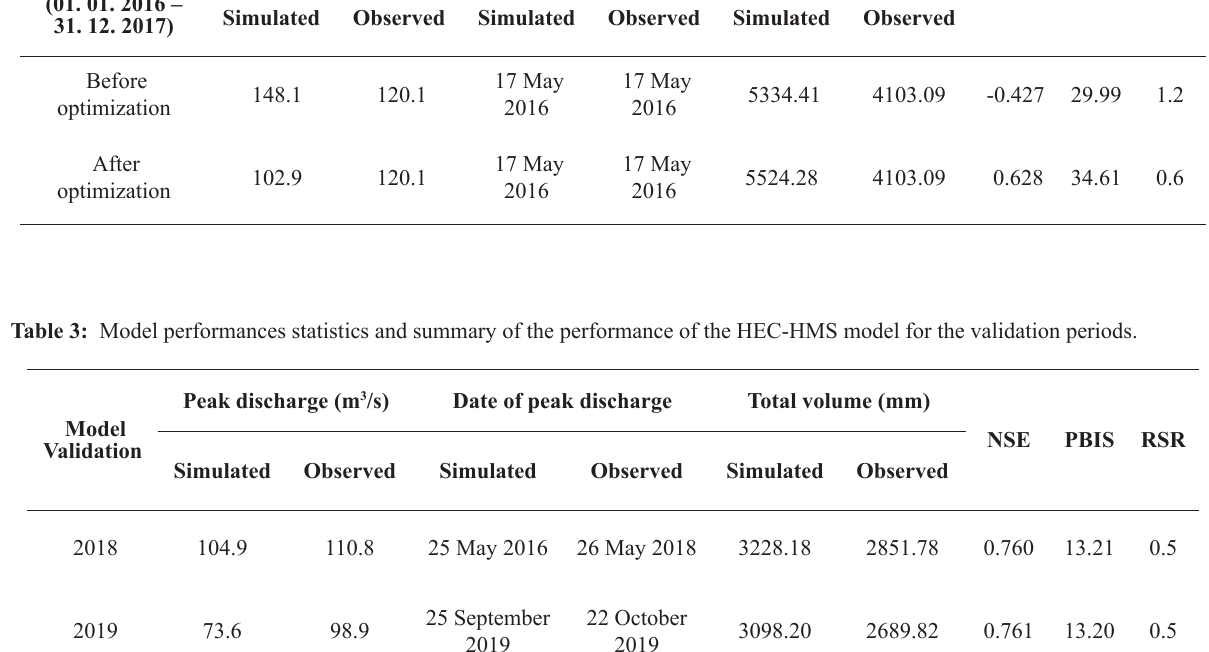
Table 2: Model performances statistics and summary of the performance of the HEC-HMS model before and the after the optimization. Model calibration